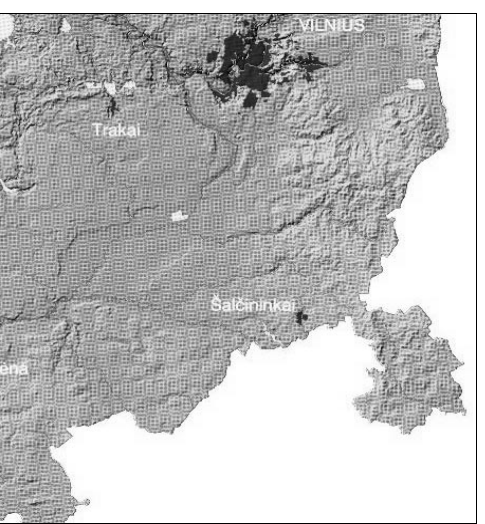
Fig 7. Fragment of morphographic map 1:500 000